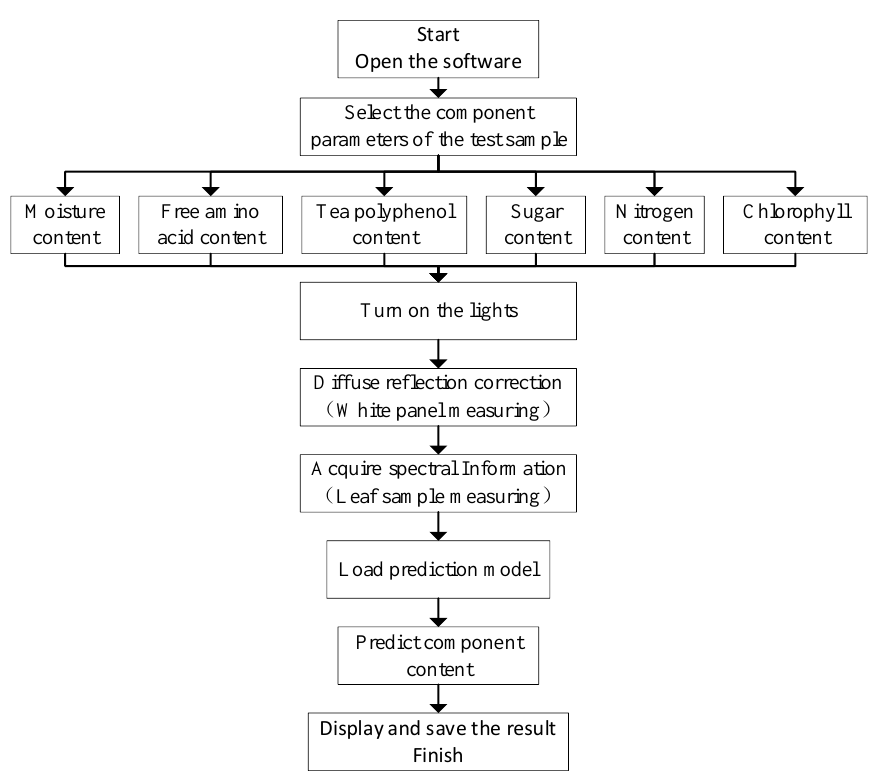
Figure 5. Flow chart of the software operation process.